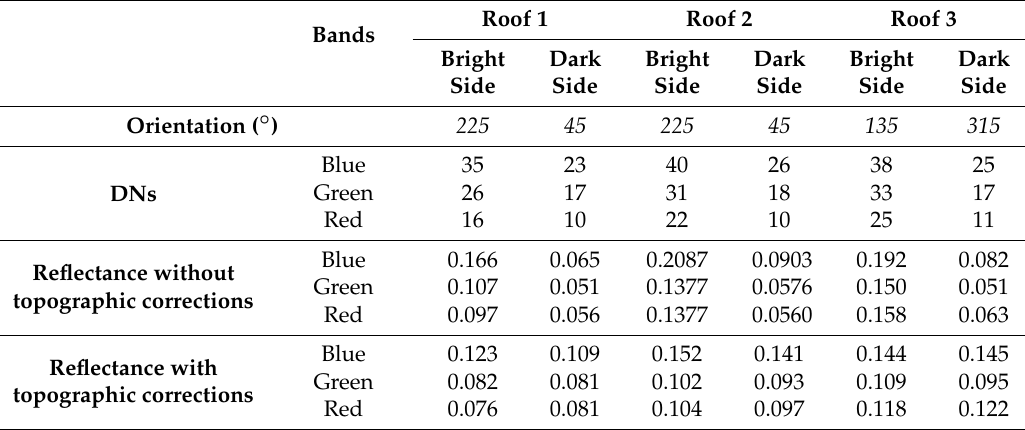
Table 7. DNs and ground reflectances without and with topographic corrections for bright and dark sides of the rooftops in Ikonos Paulatuk. Roof Bands